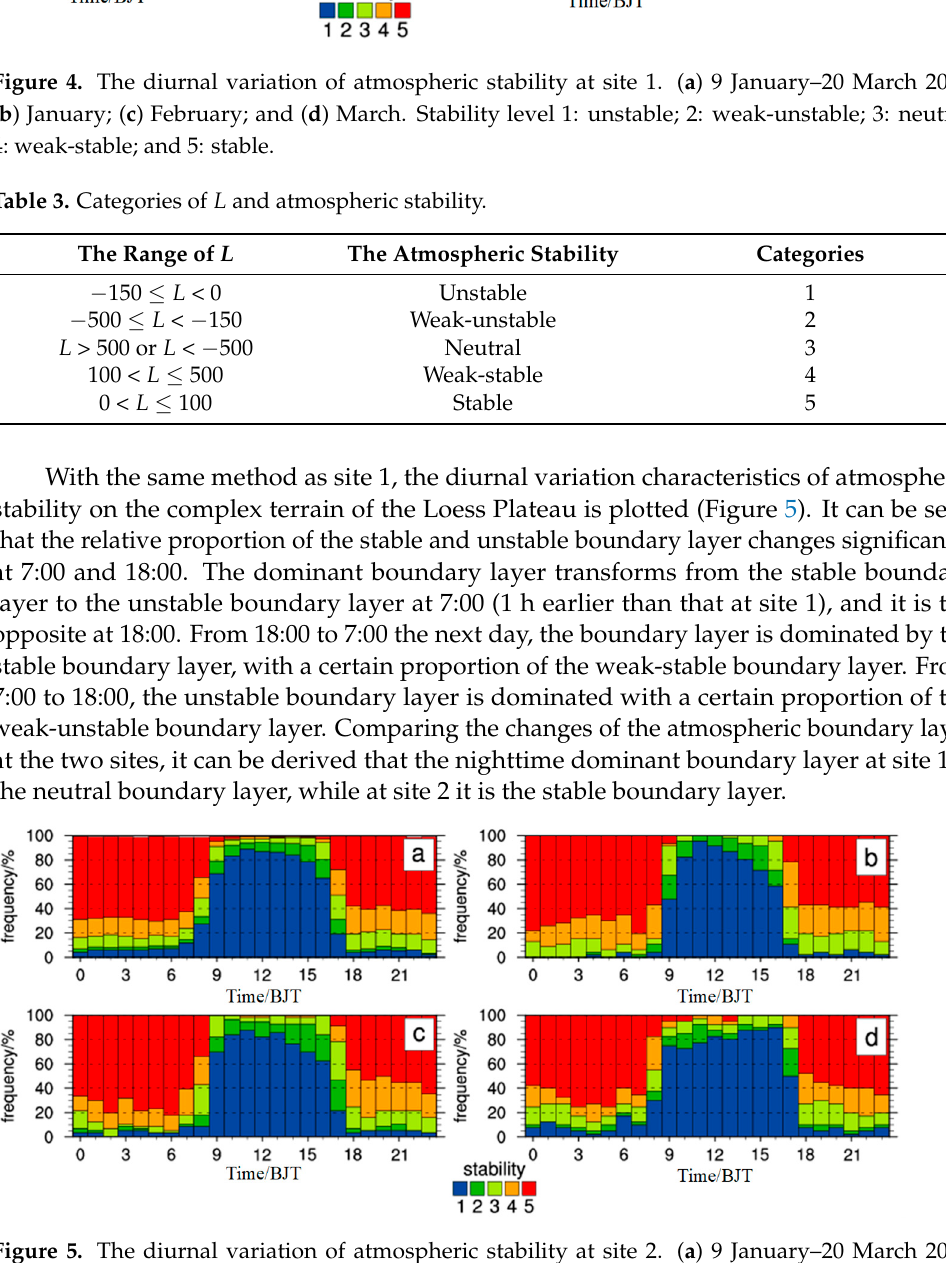
Figure 5. The diurnal variation of atmospheric stability at site 2. ( a ) 9 January–20 March